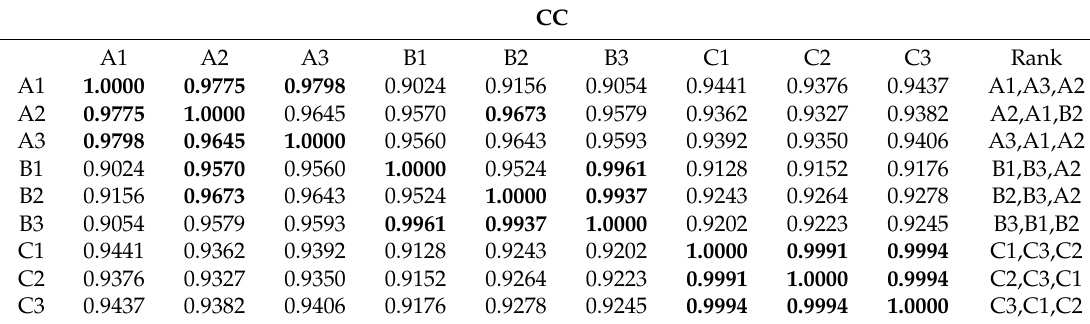
Table 7. The performance of CC for the ROSIS dataset.